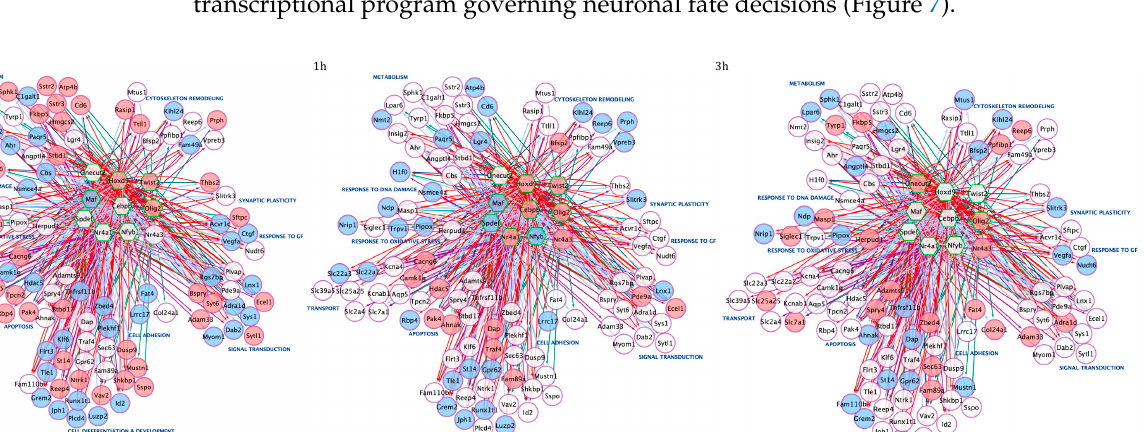
whole overview of the regulatory network of 9 key TFs together with their core set candidate targets. The network was visualized by Cytoscape . Targets are in white circle nodes with purple borders and TF in green hexagon nodes. Regulons for each TF are represented by different edge colors.